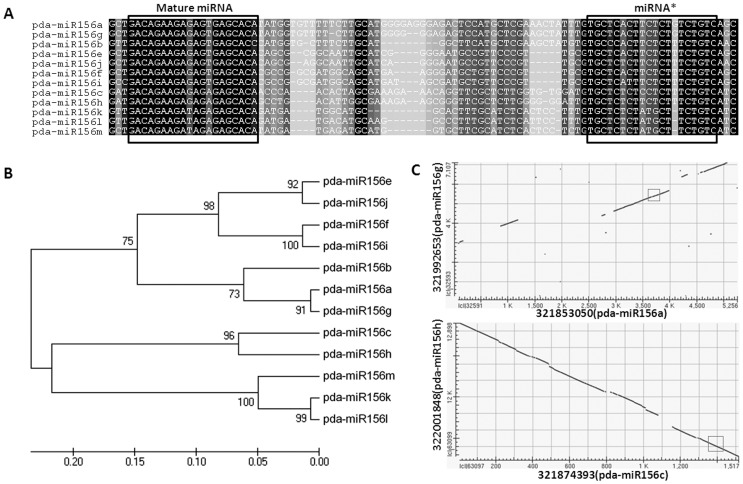
Alignment of multiple sequences and phylogenic analysis of microRNA156 pre-miRNAs in date palm.A) Alignment of twelve pre-miRNA sequences of miR156. The box to the right indicates the mature miRNA region. The box to the left indicates the star miRNA region. B) Phylogenic tree (formed by Neighbor Joining) for miRNA in the miR156 family. C) Blast2 results for two pairs of paralogous date palm contigs containing pre-miR156. Squares highlight the location of the pre-miRNAs.